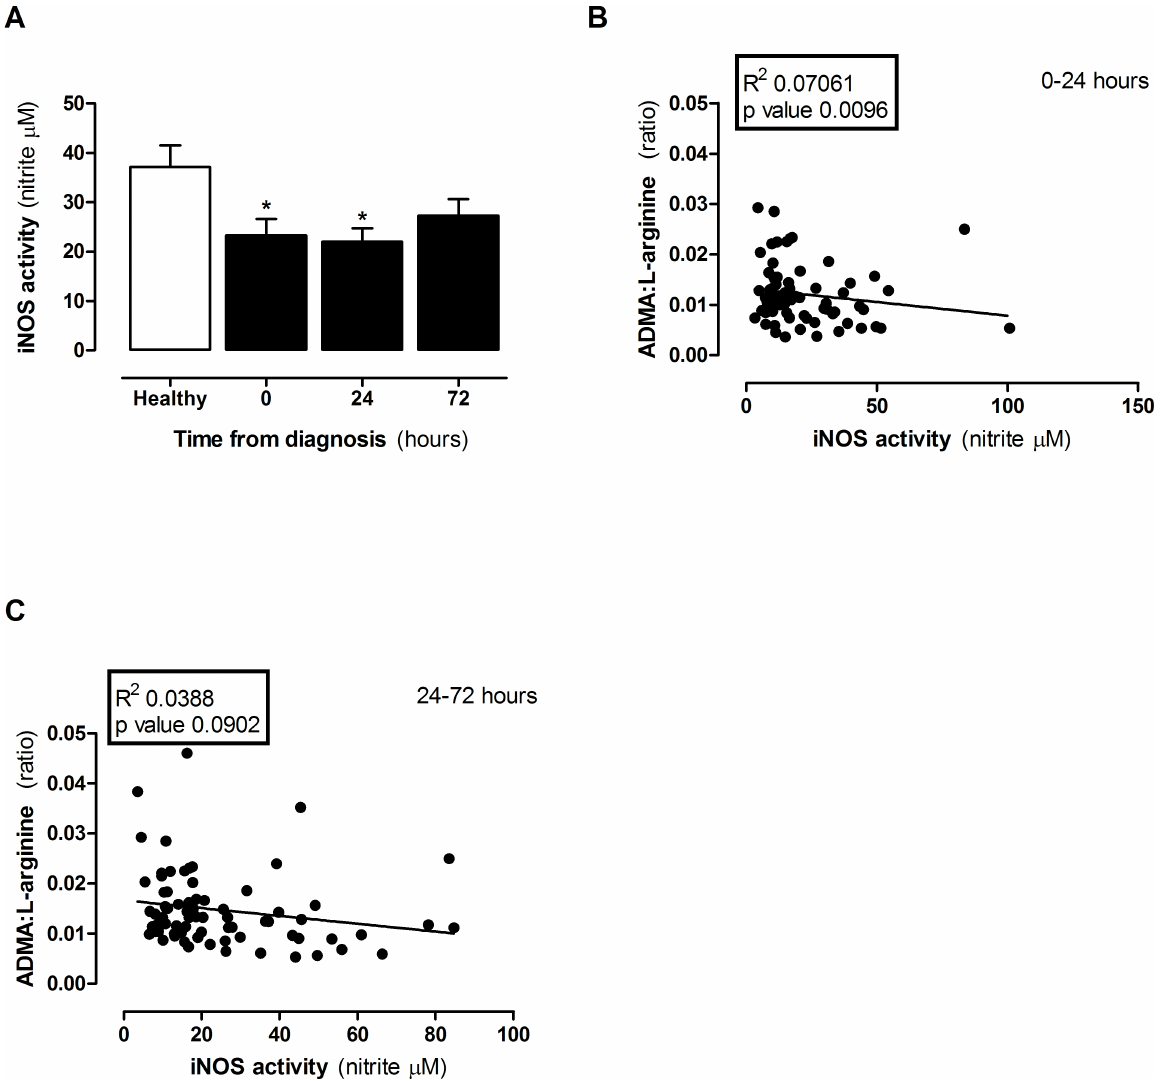
Fig 4. iNOS activity in LPS-activated mouse macrophages treated in plasma from healthy donors and patients with sepsis. (A) iNOS activity in plasma from healthyvs sepsis patients at 0, 24 and 72 hours. Correlationsin ADMA:L-arginineratio with iNOS activity at (B) 0–24 hours and (C) 24–72 hours post diagnosis. Data are mean ± SEM for n = 21 healthy donorsand n = 38 patients with sepsis. Data was analysedby (A) Kruskal-Wallis one-wayANOVA with Dunn’spost-hoc test and (B-C) linear regression. * p < 0.05 when compared to